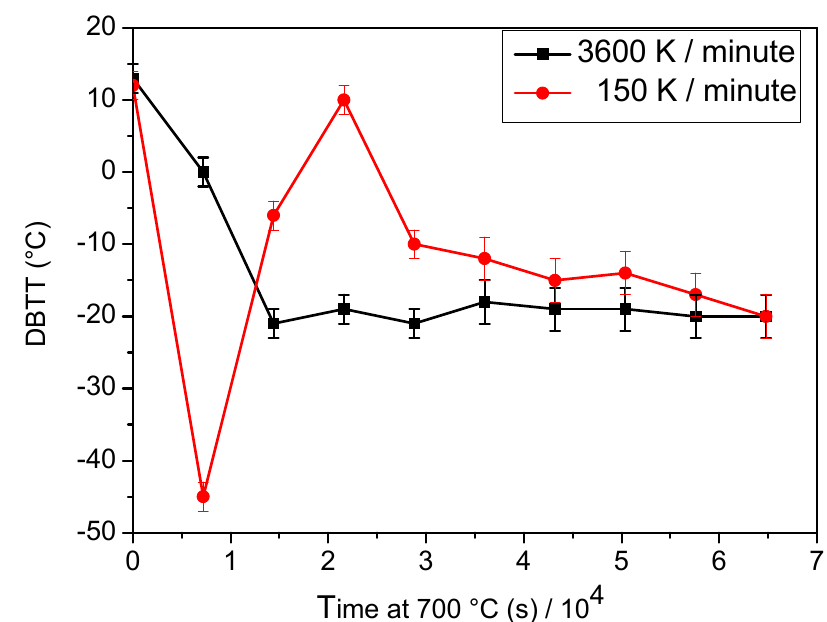
Figure 5. DBTT of the Cr martensitic steel vs. time of heat treatment at 973 K: Comparison of samples quenched from 1348 K with two cooling rates (150 and 3600 K/min).